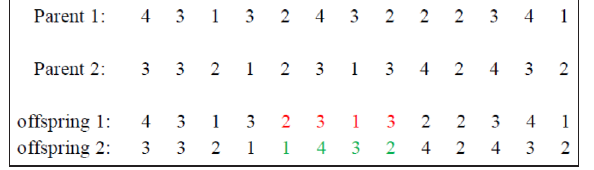
Fig. 6. The crossover